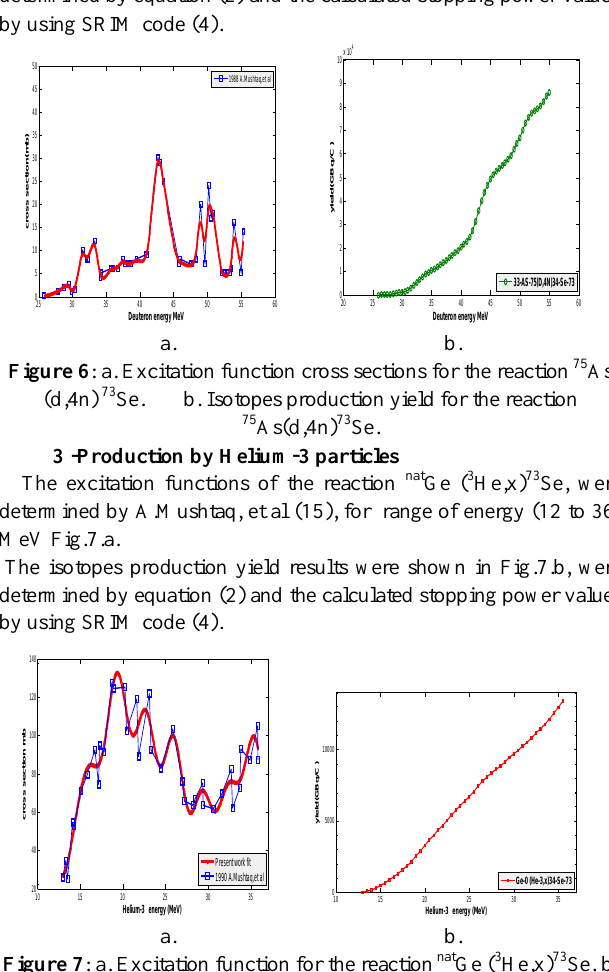
by using SRIM code (4).